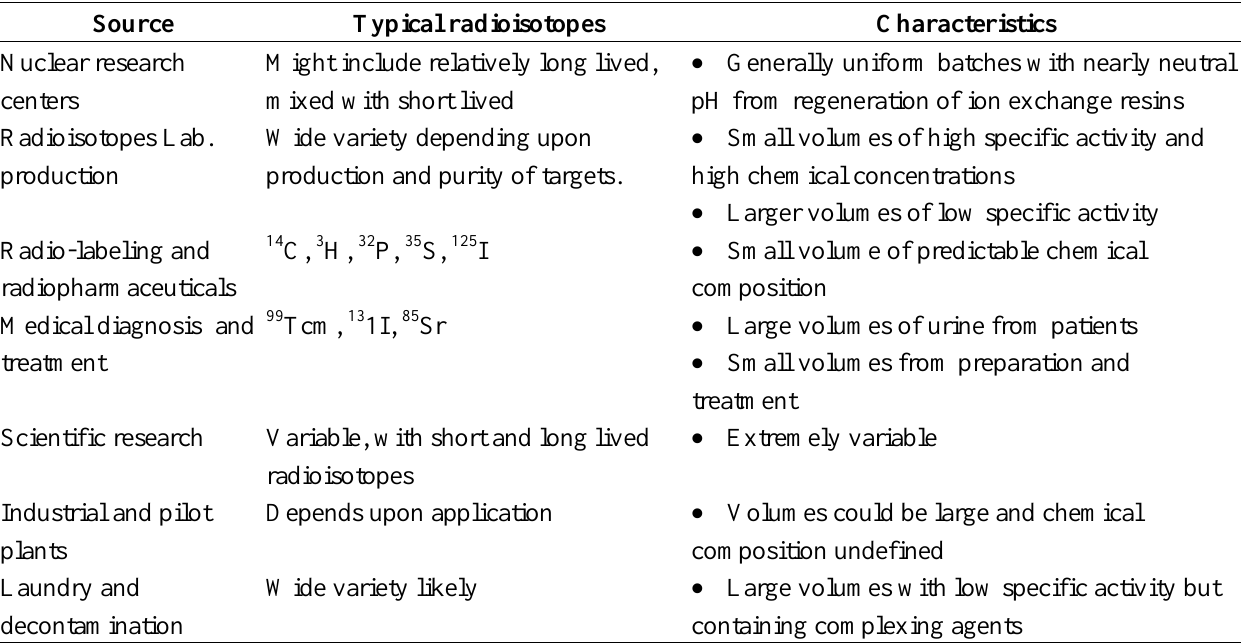
Table 2. Sources of aqueous liquid radioactive wastes